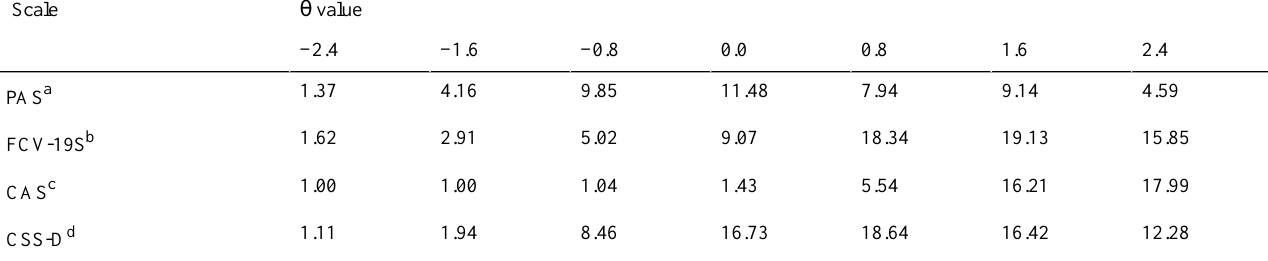
Table 7. Item information function values for each scale at θ values between –2.4 and